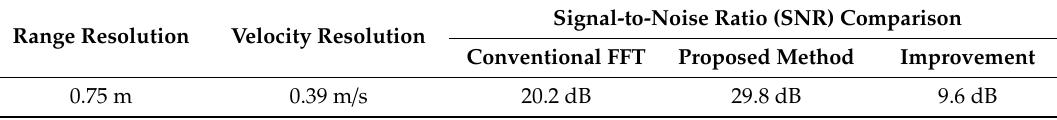
Figure 8. Comparison of the integration results. ( a ) Comparison of Doppler profiles; ( b ) comparison of range profiles. Table 4. Evaluation of the integration results.